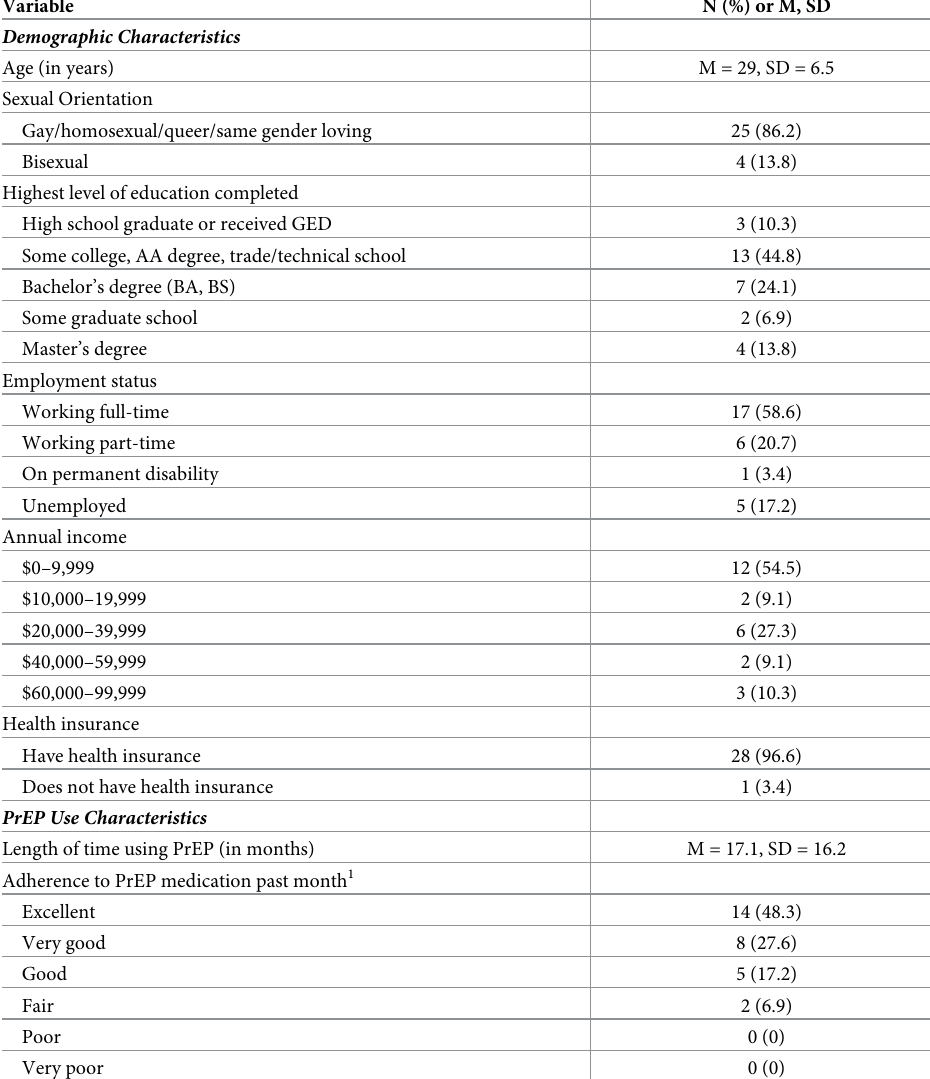
Table 1. Demographic and PrEP use characteristics (N =